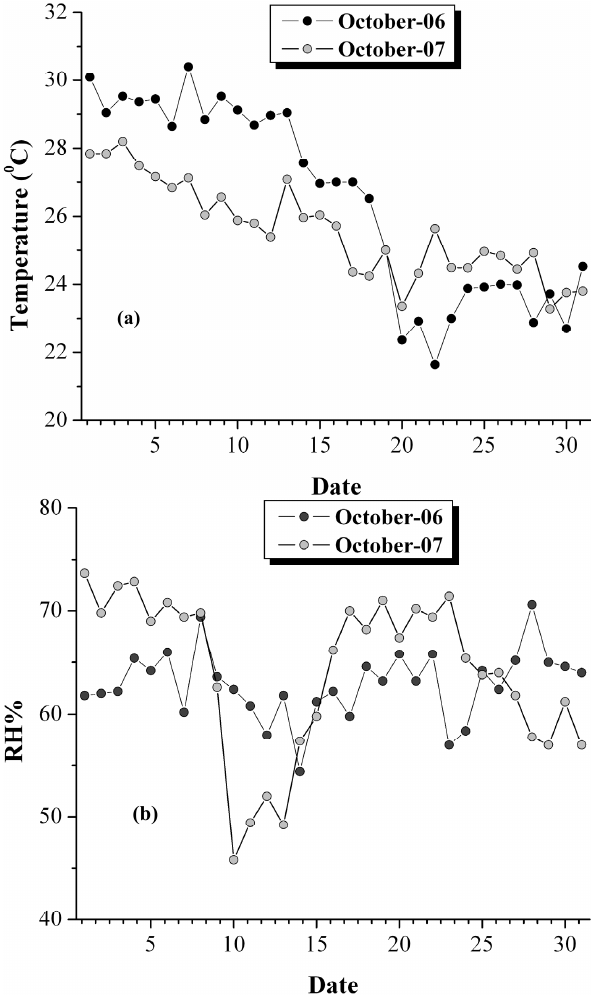
Fig. 3. Day-to-day variation of (a) average temperature and (b) Rel- ative humidity (RH) during October 2006 and